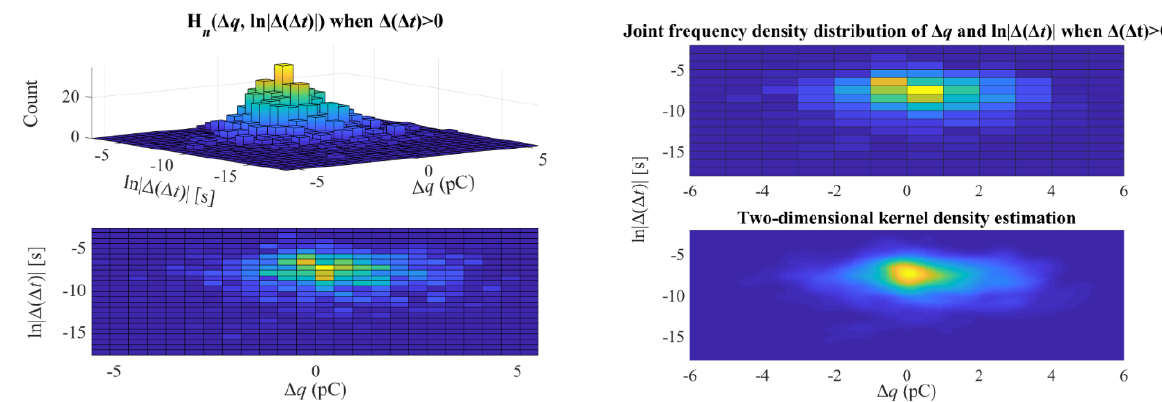
Figure 8. The illustration of H n ( Δ q , ln| Δ ( Δ t )|) and the corresponding result of two − dimensional kernel density estimation when Δ ( Δ t) > 0.